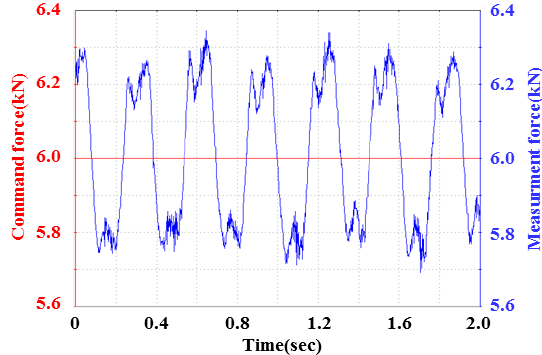
Figure 18. Radial force applied to hub bearing.